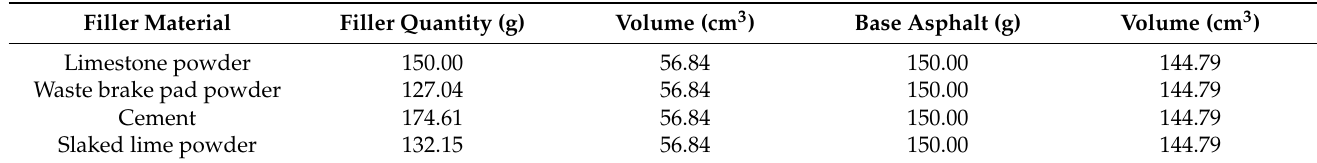
Table 12. Compositional proportions of the fillers in the asphalt mortars.